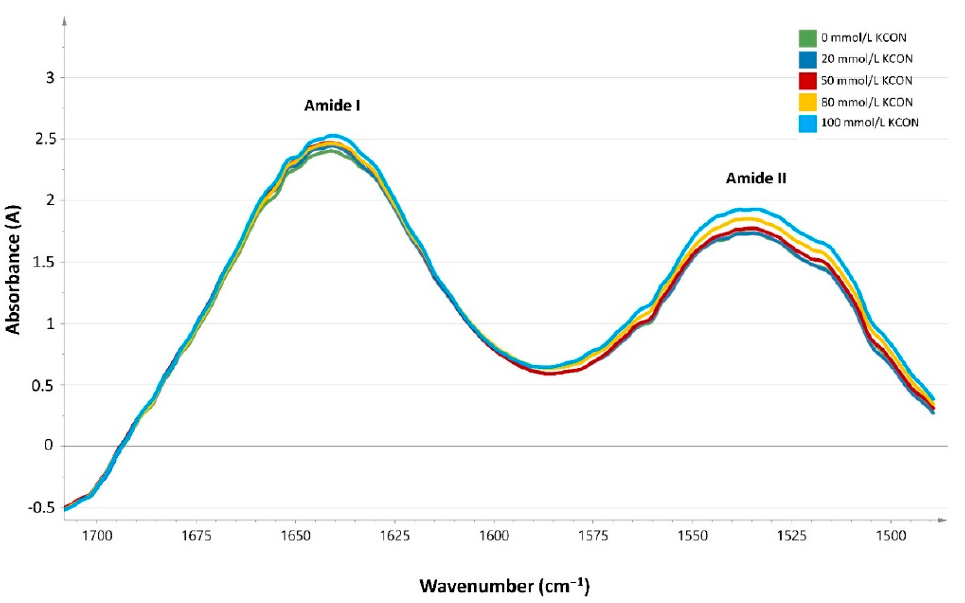
Figure 2. Absorbance spectra of in vitro carbamoylated lipids, adding increasing concentrations of potassium cyanate (0 mmol/L, 20 mmol/L, 50 mmol/L and 100 mmol/L) to serum of healthy subjects.